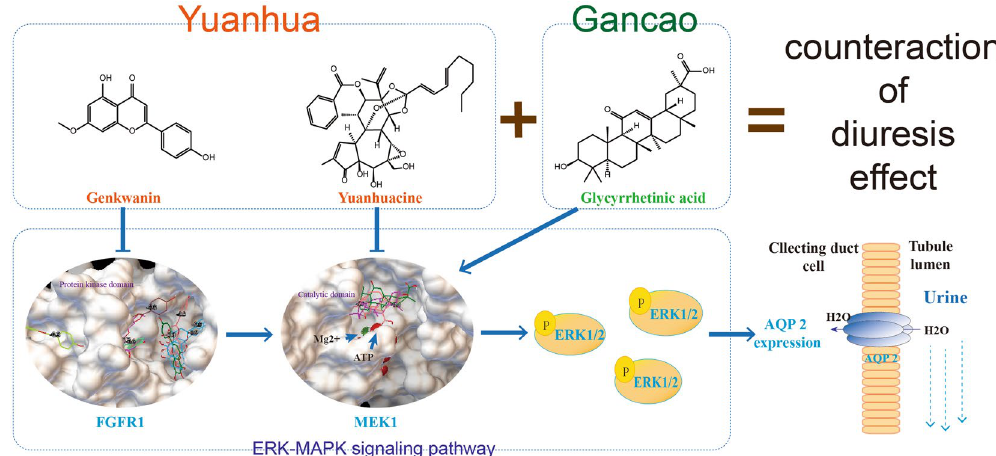
Figure 1. Research summary of this study. Our work began with evaluation of diuretic activity of Yuanhua (with or without combination of Gancao), and found that Gancao impaired the diuretic efficacy of Yuanhua. After studying some key factors in urine formation process, renal AQP 2 was proved the key target in Yuanhua’s diuretic activity and Gancao’s counteraction effect. Further, in renal collecting duct cells we found Yuanhuacine and Genkwanin dose-dependently decreased AQP 2 expression; oppositely, Glycyrrhetinic acid increased AQP 2 expression. The activity of these compounds were also verified in-vivo . Network pharmacology study revealed that these compounds could bind to MEK1 or FGFR1 protein and lead to regulations of ERK-MAPK pathway, which was verified by western blotting. At last, we conclude that the interaction in diuretic efficacy between Yuanhua and Gancao are due to differentially regulated renal AQP 2, which was mediated by ERK-MAPK signaling